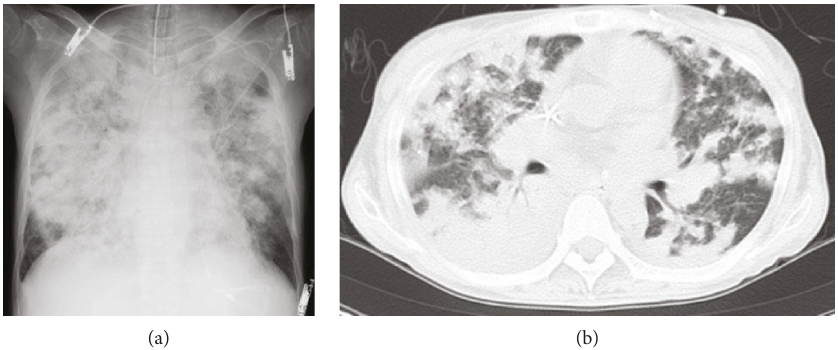
Figure 1: Preoperative chest radiography (a) and computed tomography (b) showing bilateral di ff use